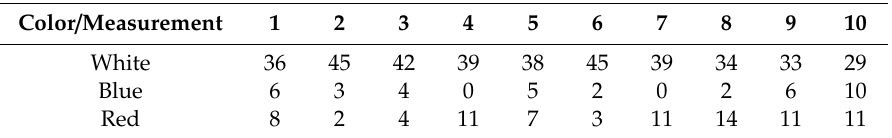
Table 6. Frequency of using the tongs.